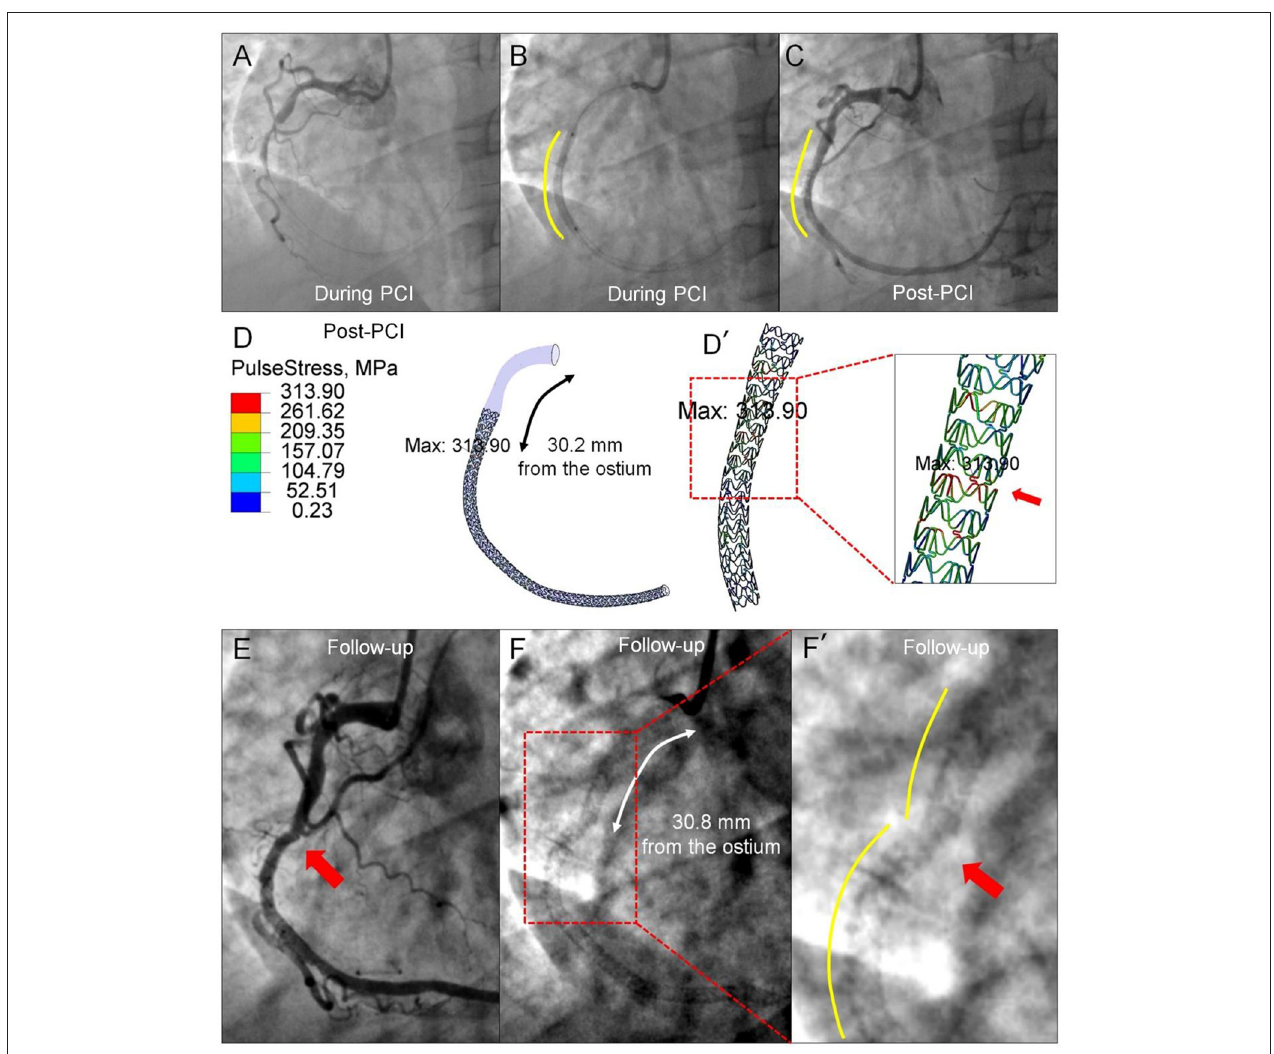
FIGURE 7 | Prediction of late stent fracture by the pulse stress on the implanted stent using angiography-based 4D coronary artery dynamic method. (A) Angiography prior to implantation shows a total occlusion of the mid-segment of the RCA and a smooth curve of the implanted stent. (B) Visible contours of the inflated balloon delineate the proximal and distal ends of the implanted stent (Xience V). (C) Straightening of the proximal segment occurs following stent implantation. (D) The highest pulse stress (313.90 MPa), derived from the difference between the stress state at end-systole and end-diastole, is found at the site of 30.2mm from the ostium. [ (D’) , red arrow] The zoomed view shows the pulse stress distribution of the implanted stent. Angiograms 20 months later show stent fracture (E) located at 30.8mm from the ostium, resulting in luminal irregularity (F) . The site of the highest pulse stress calculated by the angiography-based 4D dynamic method co-localizes with the stent fracture site [ (F’) , red arrow] documented 20 months later. higher adverse event rates (50.8 vs. 22.7%, p < 0.001) and was associated with a higher 5-year adverse event rate (hazard ratio: 2.65, p < 0.001)